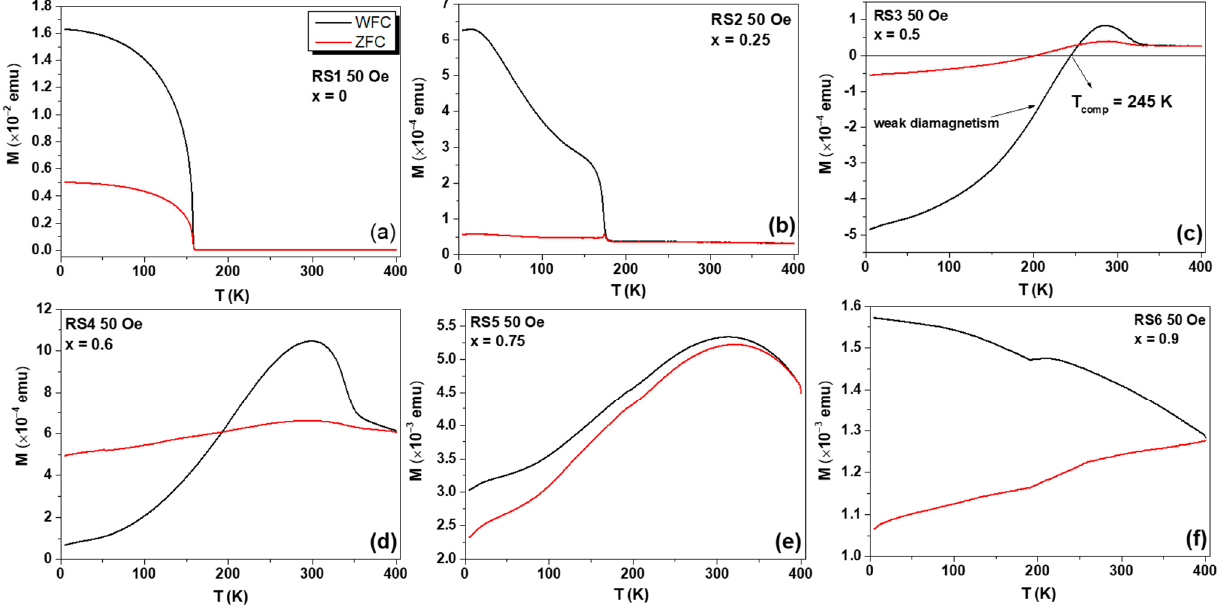
Figure 8. ZFC and WFC M(T) curves at a probe field of 50 Oe for the ( a ) RS1, ( b ) RS2, ( c ) RS3, ( d ) RS4, ( e ) RS5, and ( f ) RS6 samples.